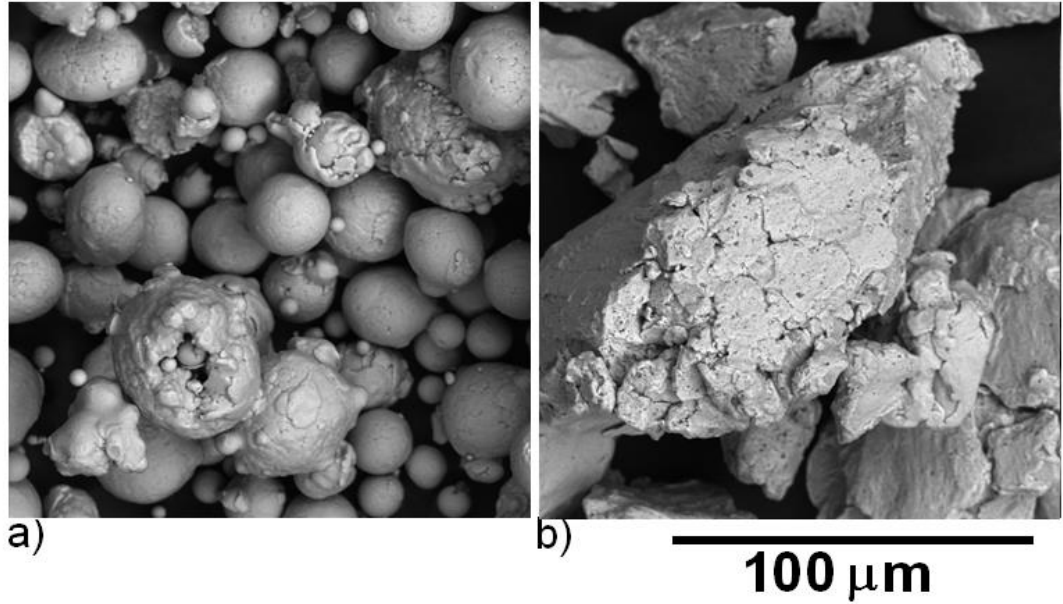
Figure 3. SEM (BSE) micrographs of Fe28Al powder particles: ( a ) original and ( b ) 1-h milled.